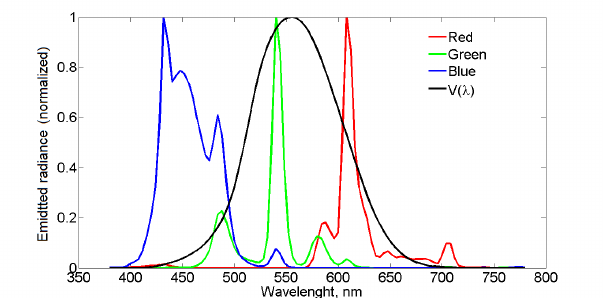
Figure 2 . Spectral power distribution for light emitted by the red, green, and blue phosphors of the experimental display and the CIE 1931 luminosity function of the standard observer, V ( λ )